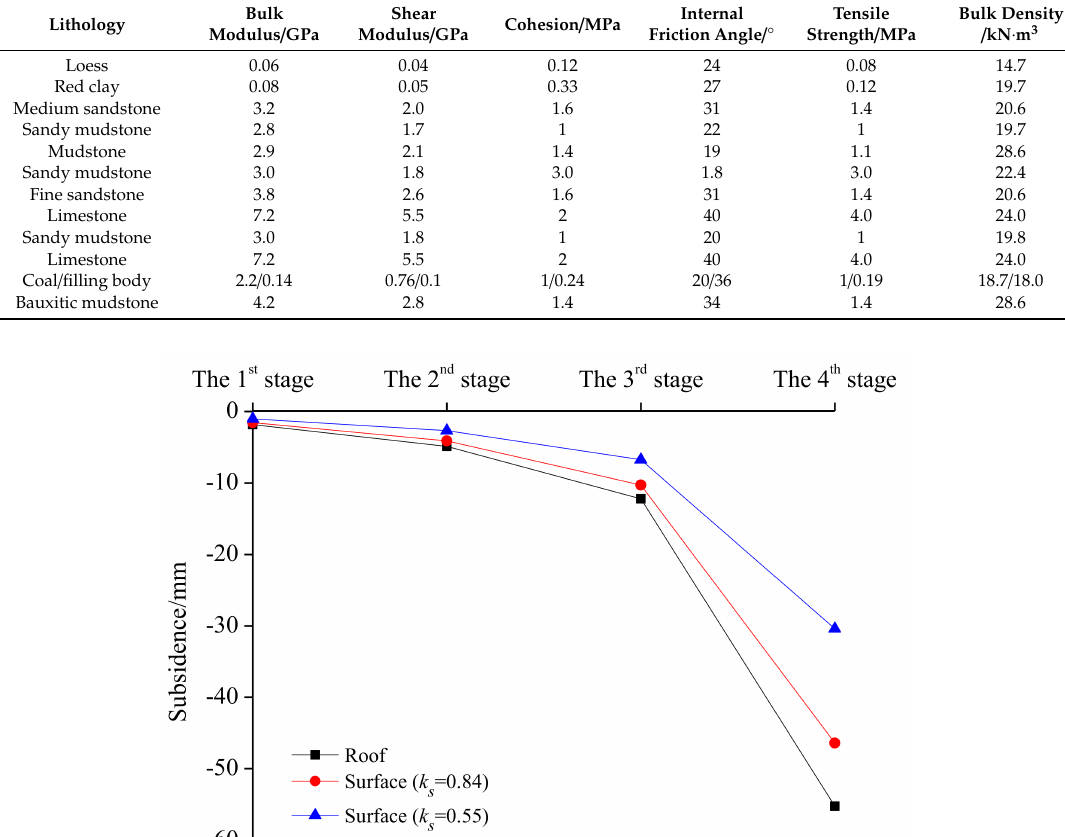
Table 3. Mechanics properties of strata and filling materials in the numerical model.